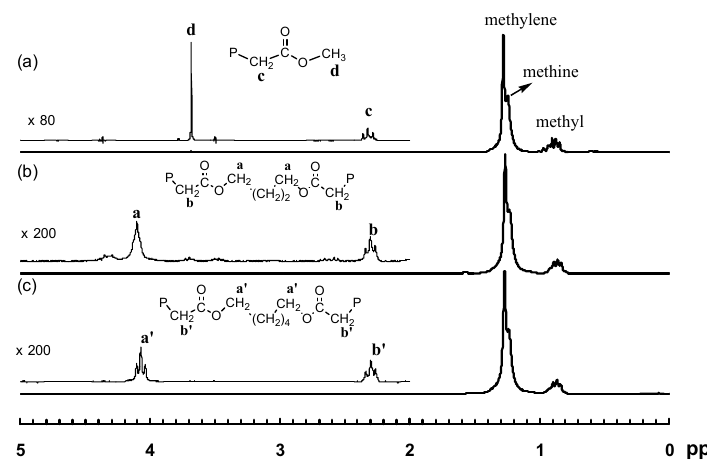
Figure 8. Polymer 1 H NMR spectra for: ( a ) 2-E400-2; ( b ) 3a-E400-2; and ( c ) 3b-E400-2. All three polymers were produced after 2 h of polymerization time.